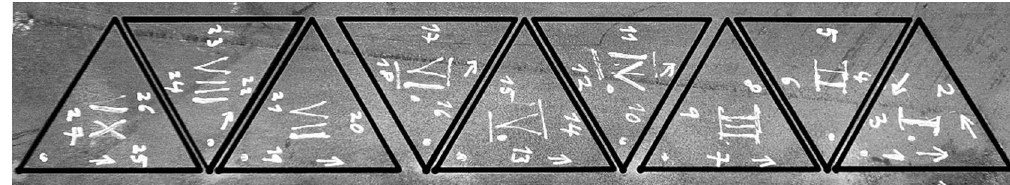
Figure 2. Example of sample marking.